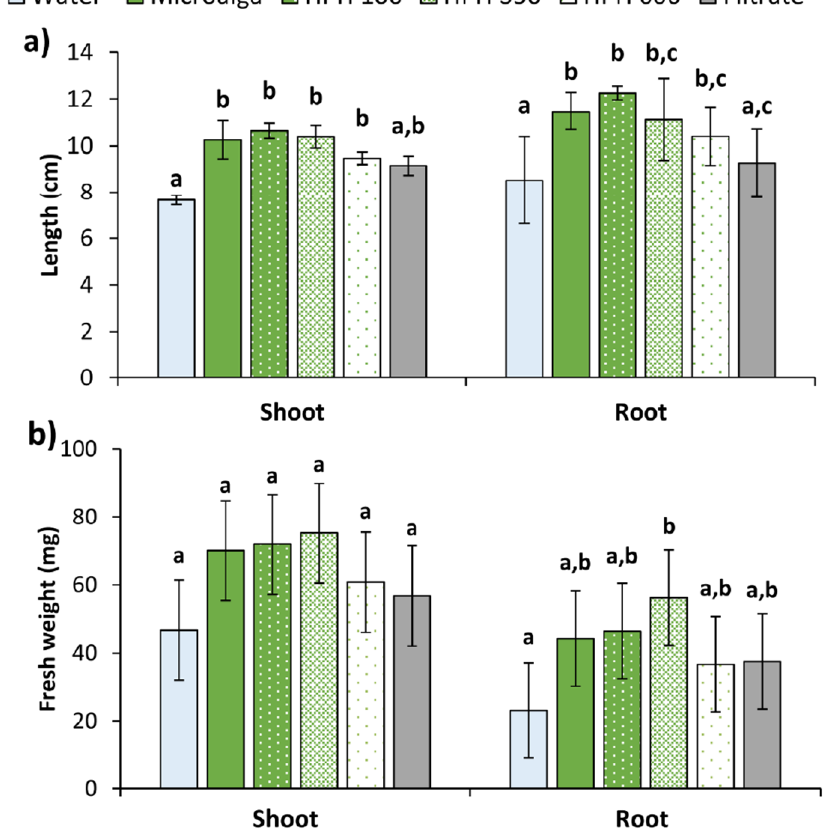
Figure 6. ( a ) Length, and ( b ) fresh weight of shoot and root of wheat plants treated with Tetradesmus obliquus after high-pressure homogenization at 100, 350, and 600 bar (1 cycle), non-disrupted microalga culture, and its filtrate compared to distilled water (control). Different letters indicate significant differences among treatments (Tukey’s test, p < 0.05) and data are shown as mean ± pooled standard deviation ( n =